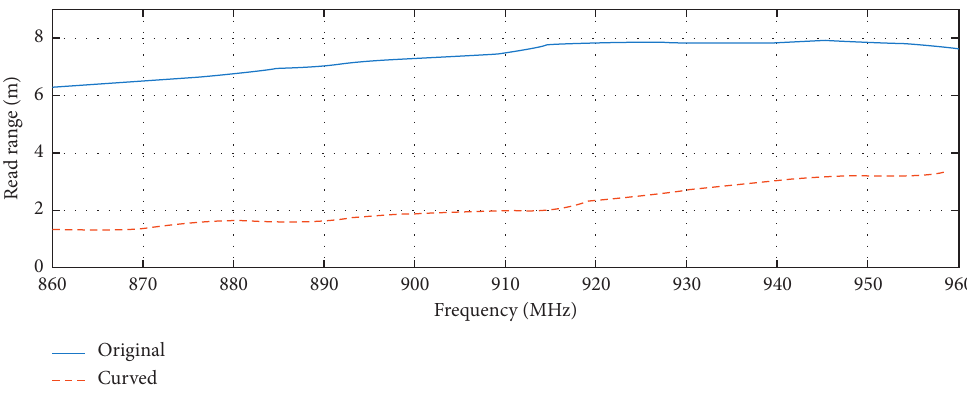
Figure 9: Read range measurements of the sensor tag at the unbent and bent